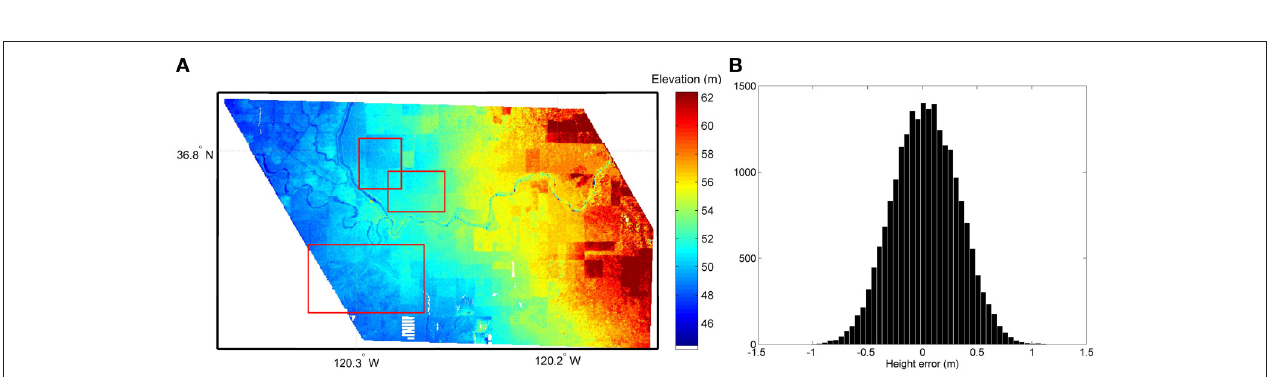
FIGURE 4 | (A) 30 30m InSAR DEM showing subregions used for accuracy assessment (red rectangles). (B) Histogram of relative height error between the final × InSAR DEM and the LiDAR bare ground DEM.